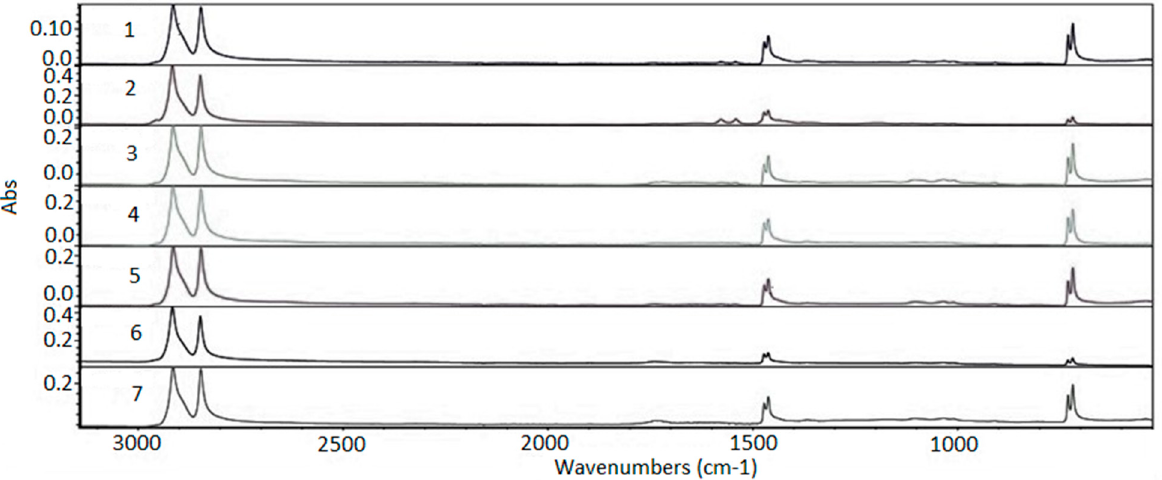
Figure 6. Absorption spectra region from 600 to 3100 cm − 1 . 1—virgin sample; 2—960 h Xenon arc sample; 3—1639 h Xenon arc sample; 4—2160 h Xenon arc sample; 5—960 h UV fluorescent sample; 6—4380 h UV fluorescent sample; and 7—8760 h UV fluorescent sample.